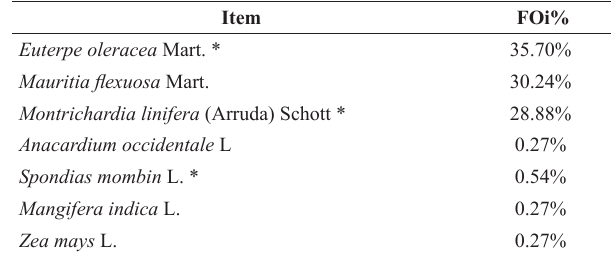
Tab. 1. Frequency of Occurrence (FOi%) of fruits and